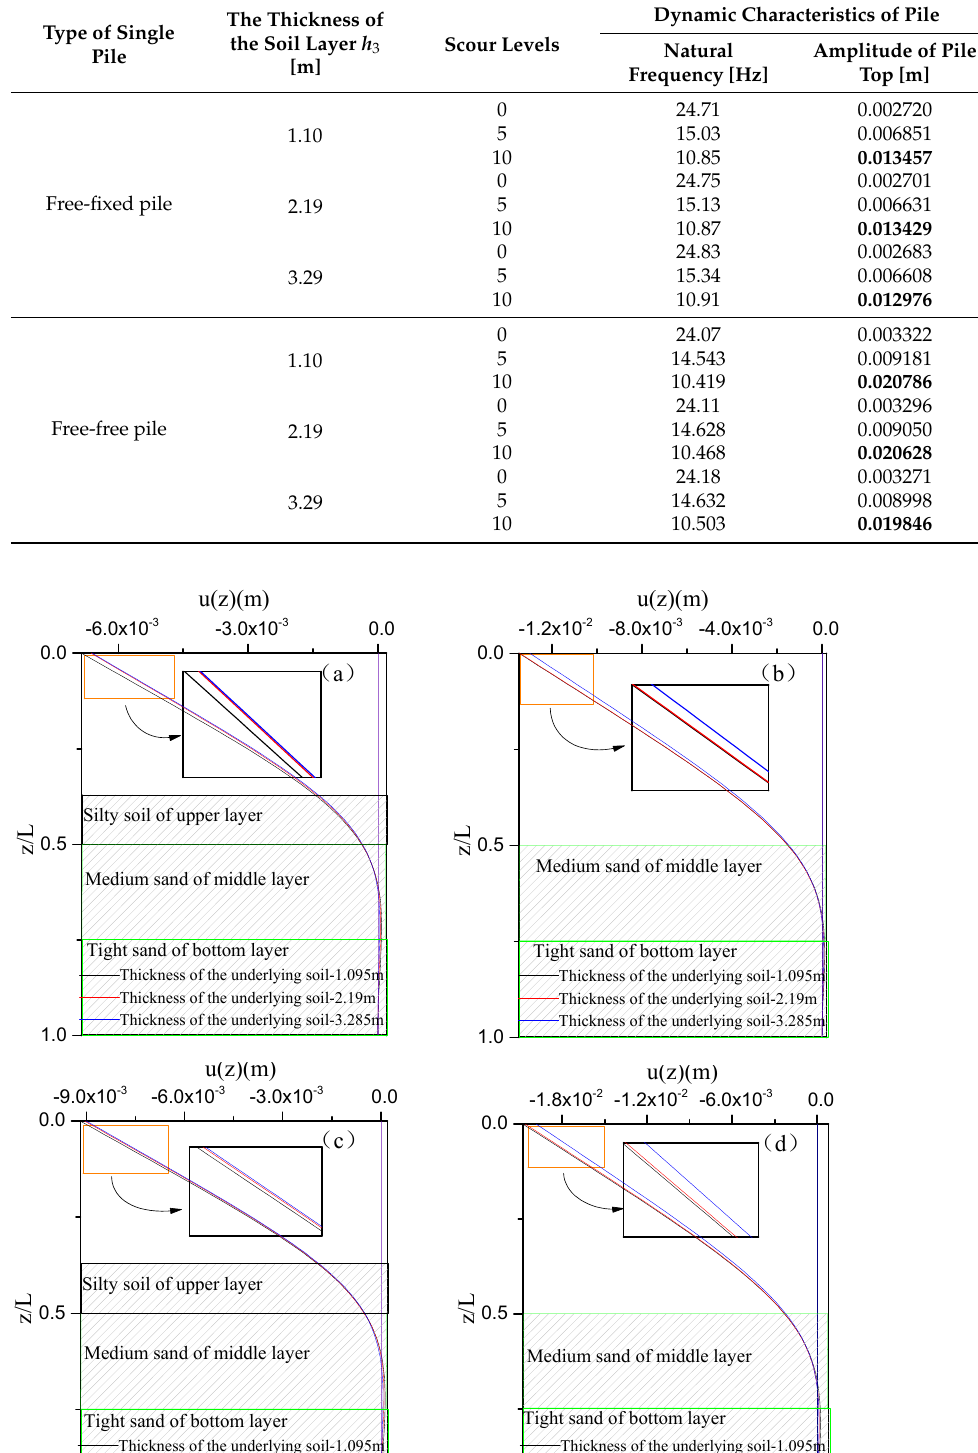
Figure 7. Effect of the thickness of soil on the dynamic response of the single pile under varied scour levels: ( a ) Free-fixed pile, scour level-5; ( b ) Free-fixed pile, scour level-10; ( c ) Free-free pile, scour level-5; ( d ) Free-free pile, scour level-10.